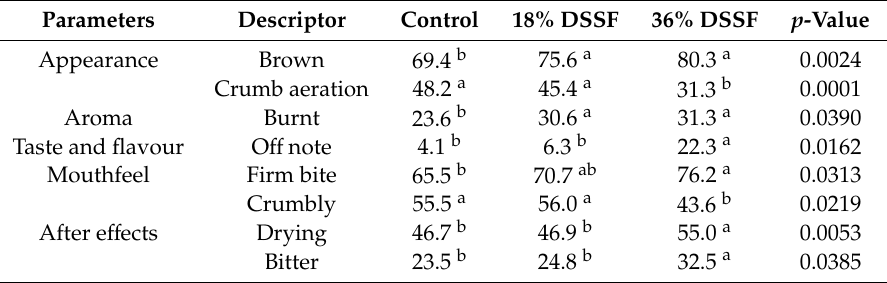
Figure 3. Sensory scores of descriptors that differed significantly between biscuits (control, 18% and 36% defatted sunflower seed flour). Table 4. Sensory scores of control and defatted sunflower seed flour biscuits.